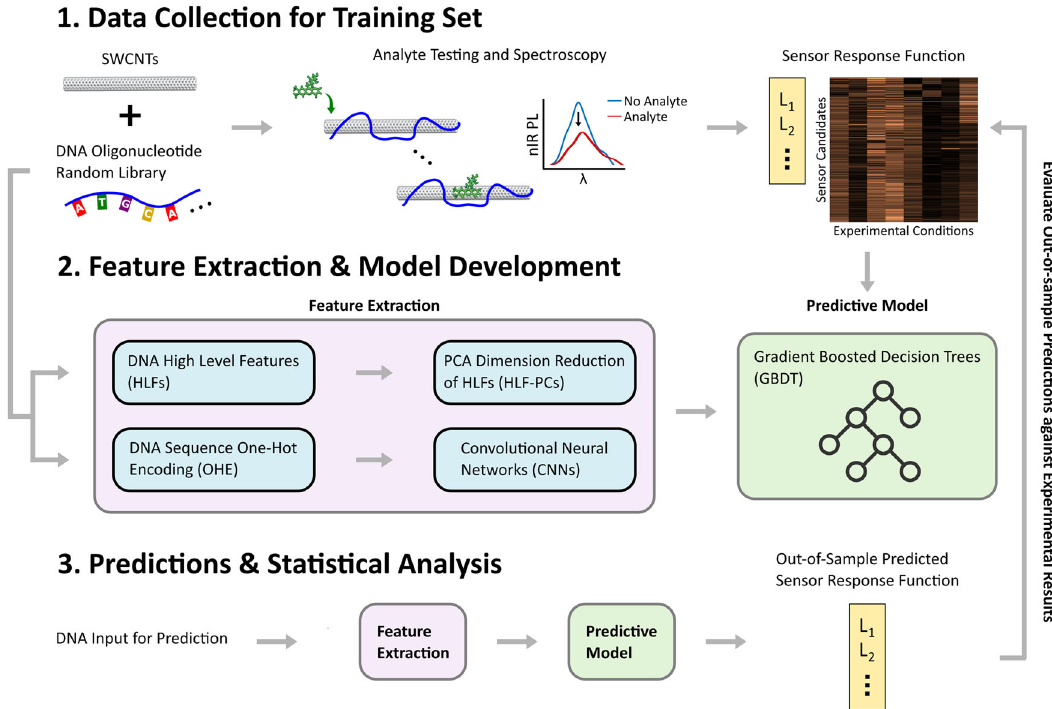
Fig. 1 Overall experimental and computational scheme for data generation, including the collection, processing, modeling and analysis of the photophysical response data from our sensors. 1 First, DNA-SWCNT dispersions from a library of sequences. These sensor candidates were then tested against the analytes of interest under different pH conditions in this study, resulting in nIR spectral changes measured between 850 and 1250 nm. The model input is created by converting the before and after spectra from each analyte incubation into an optimizable score, Eq. (1) and Eq. (2), through the sensor response function. 2 The DNA sequences were encoded via 2 methods: direct vectorization/one-hot encoding or through calculations of common high-level features (HLFs). Using these two types of inputs, predictive models using gradient-boosted decision trees (GBDTs) were created. 3 Finally, the model is used to score potential MR designs and evaluated in out-of-sample analysis against laboratory